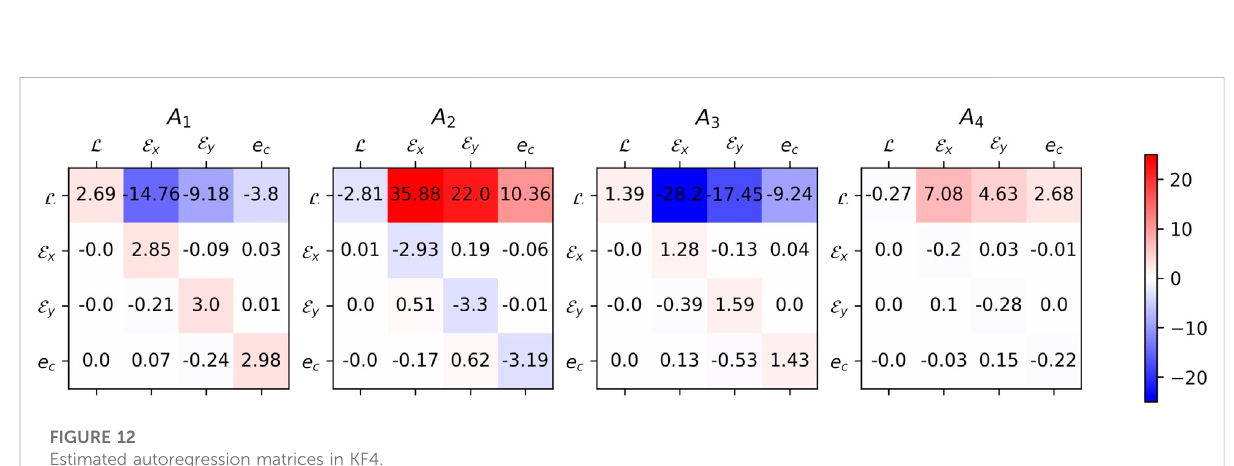
Estimated autoregression matrices in